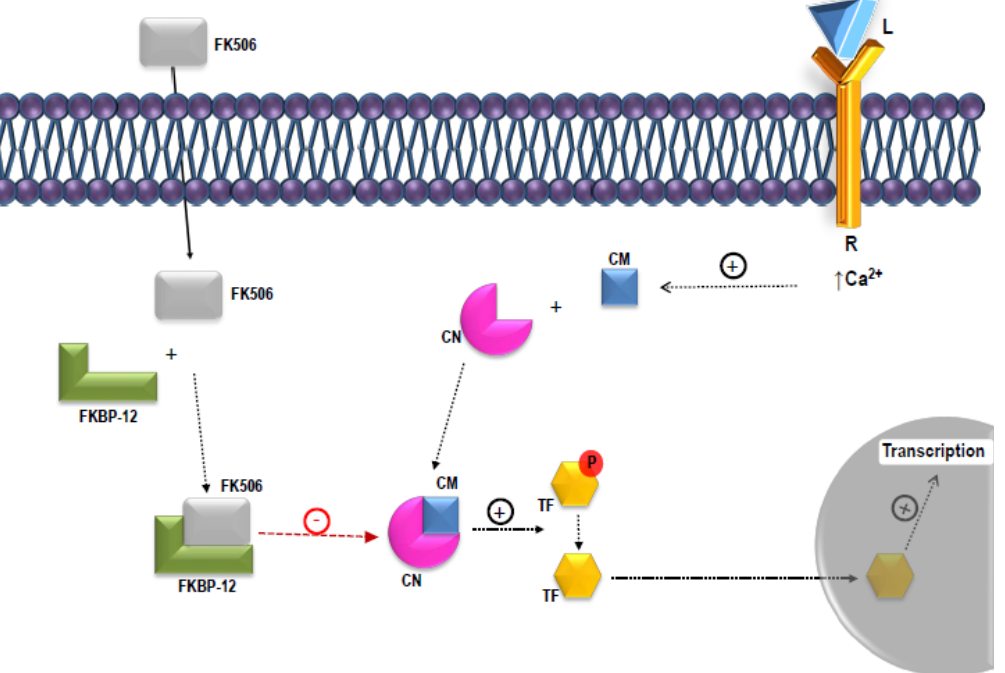
Figure 1. Mechanism of action of tacrolimus (FK506). Tacrolimus interacts with cytosolic receptors such as FKBP12. The complex FKBP12-FK506 inhibits the calmodulin-dependent serine/threonine phosphatase activity of calcineurin. In this situation, calcineurin can no longer dephosphorylate transcriptional factors (e.g., NFAT). The dephosphorylated TFs are required for governing T cell proliferation. L: ligand; R: receptor; CM: calmodulin; CN: calcineurin; TF: transcription factor; P: phosphate group; FKBP-12: FK506 binding protein 12.